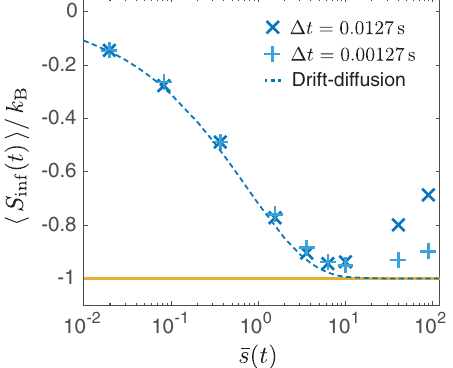
FIG. 5. Cumulative distributions of the infimum of entropy production for a Smoluchowski-Feynman ratchet in a steady state for different values of the mean entropy change ¯ s ð t Þ ¼ h S t Þi =k . Simulation results for the Smoluchowski- tot ð B Feynman ratchet with the potential (79) (solid lines) are com- pared with analytical results for the drift-diffusion process given by Eq. (81) (dashed lines), and with the universal bound given by 1 − e − s (rightmost yellow curve). Simulation parameters: 10 4 300 K, l ¼ 2 π nm, γ ¼ 8 . 4 pN s = nm, simulations with T env ¼ V k T , simulation time step Δ t ¼ 0 . 00127 s, and total 0 ¼ B env simulation time t ¼ 0 . 4 s. The external force F and the drift velocity v are determined by the average entropy production ¯ s ð t Þ .